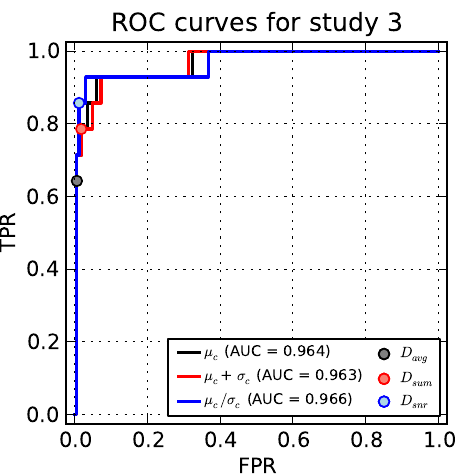
Fig. 9. ROC curves for the 180 simulations in study 3 using the SVM committee with three decision variables ( µ c , µ c + σ c , and µ c /σ c ). The locations of the discriminators using the fixed thresholds in D avg , D sum , and D snr are also shown.